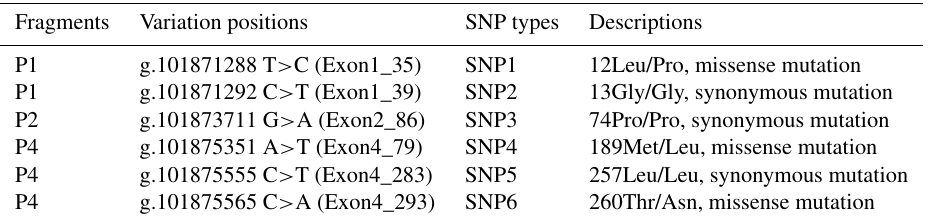
Table 2. Genotypes of different mutations corresponding to PCR-SSCP types in